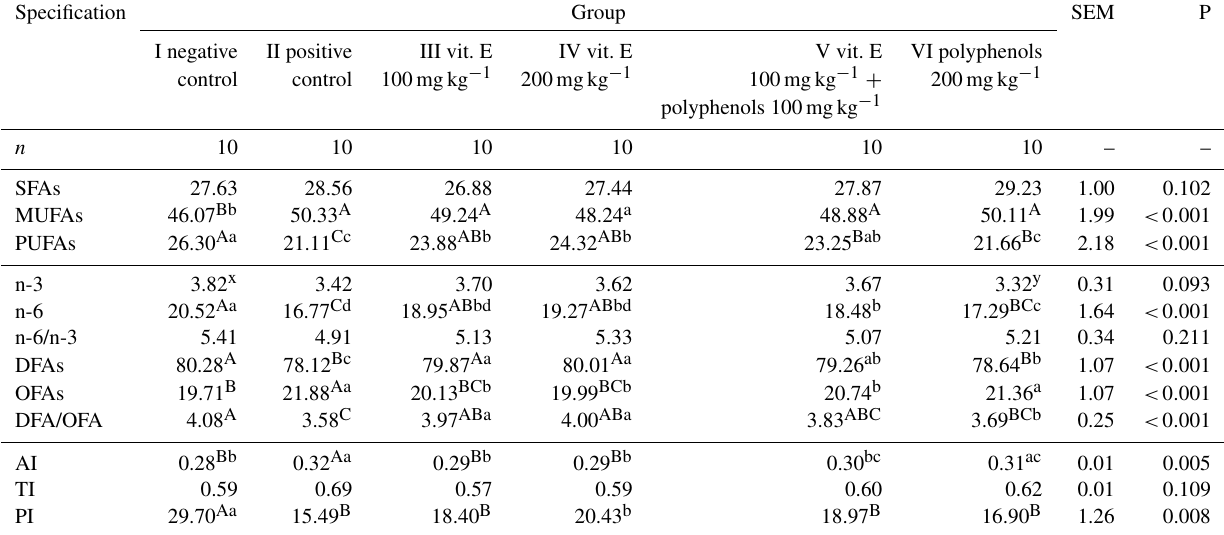
Table 7. Percentage content of fatty acids in the breast muscles of broiler chickens.